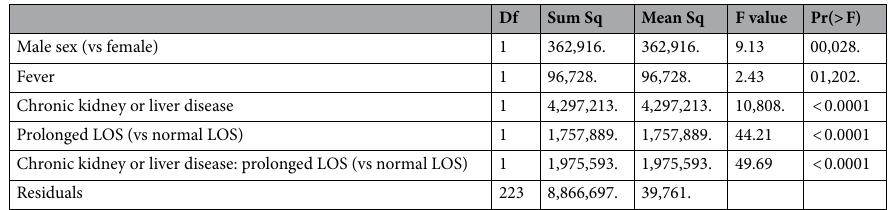
Table 3. Repeated-measures ANOVA of creatinine